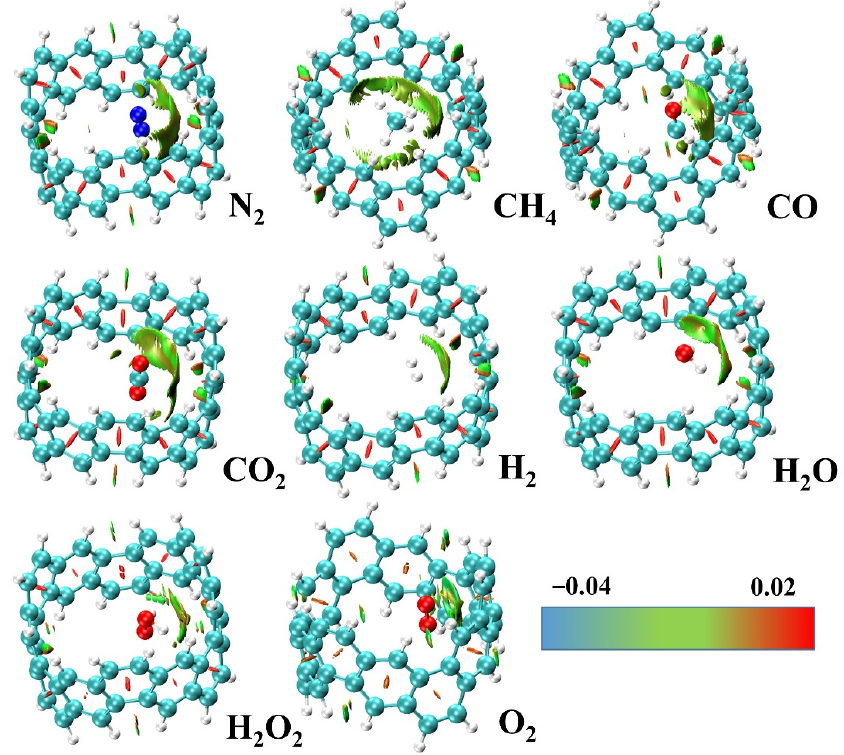
Figure 5. The optimized structure and RDG diagram (isovalue = 0.5) of small molecules adsorbed on the inside of [6, 6] CNB. The surfaces between the [6, 6] CNB and the adsorbates correspond to the isosurface of RDG mapped by sign ( λ _2 ) ρ function, in